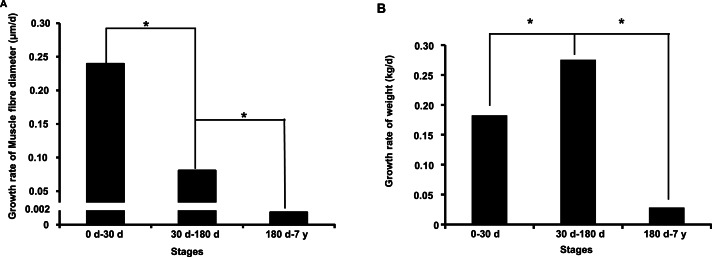
Growth rate of muscle fiber diameter (A) and weight (B) during the postnatal muscle development stage.Three replicates were used when performed the statistical analysis between different development stages. “*” indicates significant difference (Student’s t-test, P < 0.05).